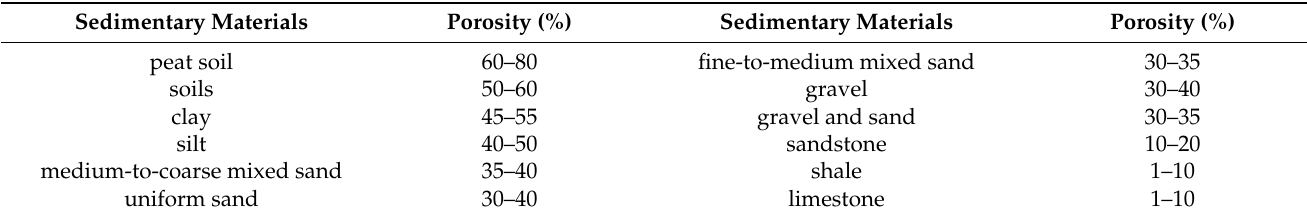
Table 1. Typical porosity values of natural sedimentary materials